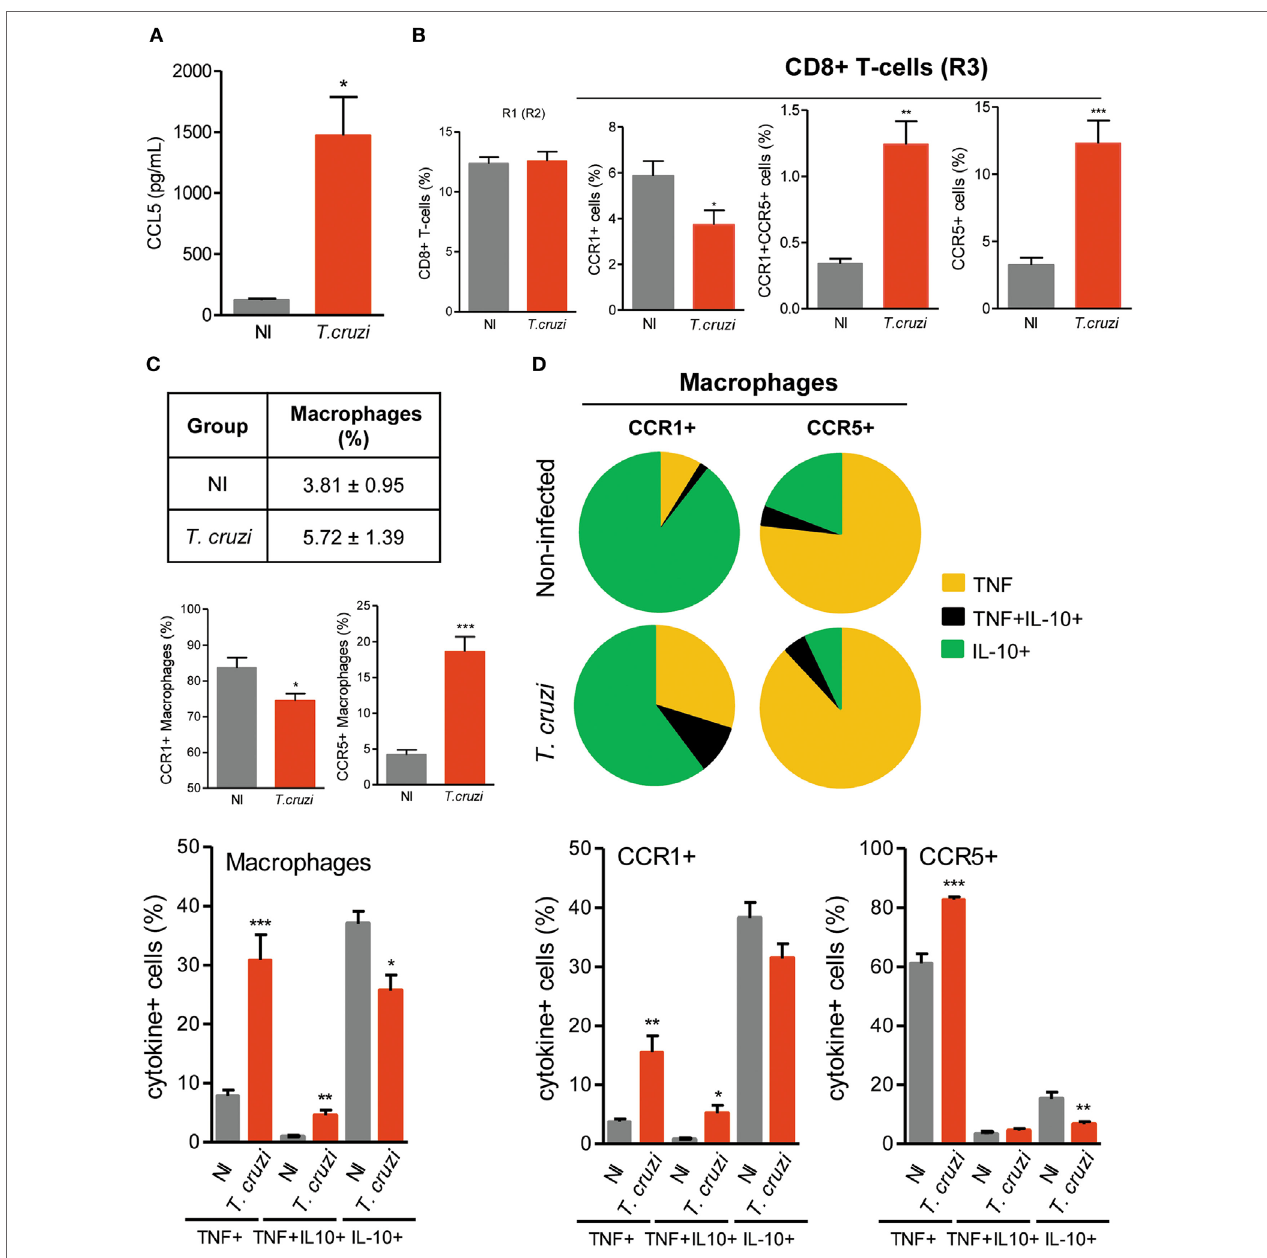
FigUre 2 | CCL5 levels and CCR1 and CCR5 expression in CD8 + T cells and CD14 + macrophages of T. cruzi -infected C57BL/6 mice. Mice were infected with 100 trypomastigote forms of the Colombian T. cruzi strain and analyzed at 120 days postinfection. The heart was removed, proteins were extracted, and CCL5 concentrations were estimated by enzyme-linked immunosorbent assay. Splenocytes were collected and stained for intracellular cytokines (TNF, IL-10) and surface cell markers (CD8, CD14, CCR1, CCR5). (a) CCL5 levels in the heart tissue extracts of T. cruzi -infected mice compared to noninfected (NI) controls. (B) Percentages of total CD8 + T cells and CD8 + T cells expressing CCR1 and/or CCR5 in the spleen of NI and T. cruzi -infected mice. (c) The table shows percentages of total CD14 + macrophages. Graphs show the frequencies of CD14 + macrophages expressing CCR1 or CCR5 and CD14 + macrophages expressing TNF, TNF/IL-10, or IL-10 in the spleen of NI and T. cruzi -infected mice. (D) Pie charts represent the fractions of CCR1 + or CCR5 + CD14 + macrophages carrying each of the intracellular cytokine phenotypes shown in the legend. Graphs show the frequencies of CCR1 + or CCR5 + CD14 + macrophages expressing TNF, TNF/IL-10 or IL-10. Data represent two independent experiments with three NI and five to seven infected mice [* P < 0.05, ** P < 0.01, *** P < 0.001, T. cruzi -infected mice vs NI (Student’s t